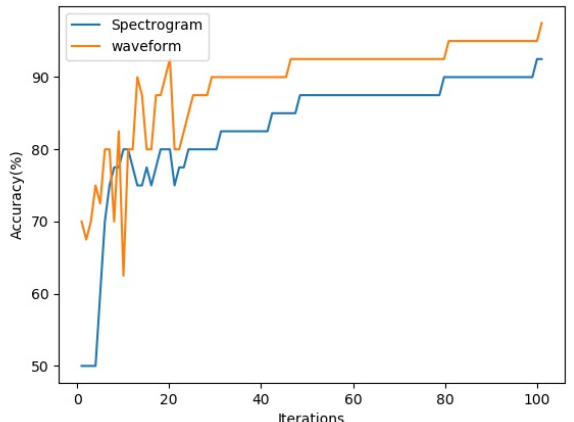
Figure 2. Iterative training results of violent behavior based on auditory features.